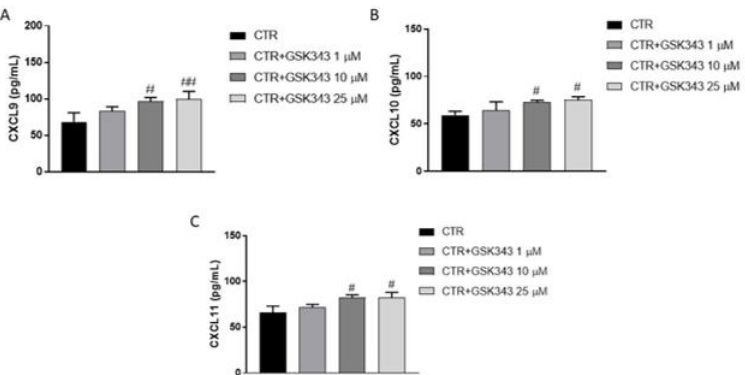
Figure 11. ELISA assay revealed that GSK343 treatment (10 and 25 μM) increased CXCL9, CXCL10 and CXCL11 levels ( A – C ) compared to the control group. No significance was revealed for the treat- ment 1 μM. Data are representative of at least three independent experiments. ( A ) # p < 0.05 vs. Ctr; ## p < 0.01 vs. Ctr; ( B ) # p < 0.05 vs. Ctr; ( C ) # p < 0.05 vs.